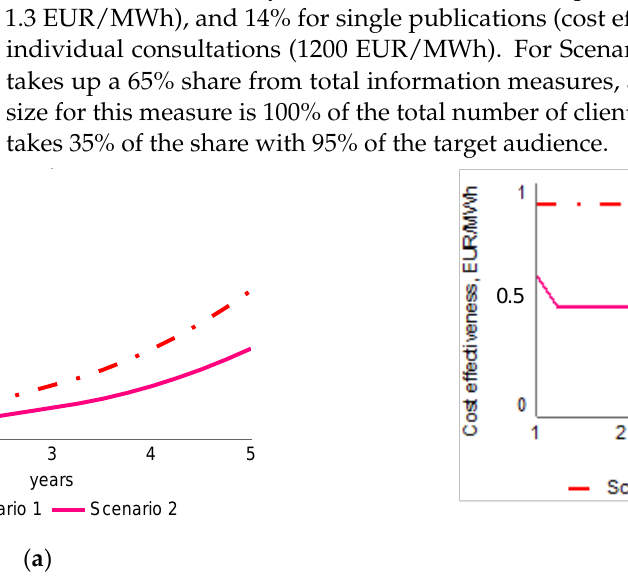
Figure 9. Actual cumulative costs ( a ) and cost-effectiveness for simulation scenarios ( b ).